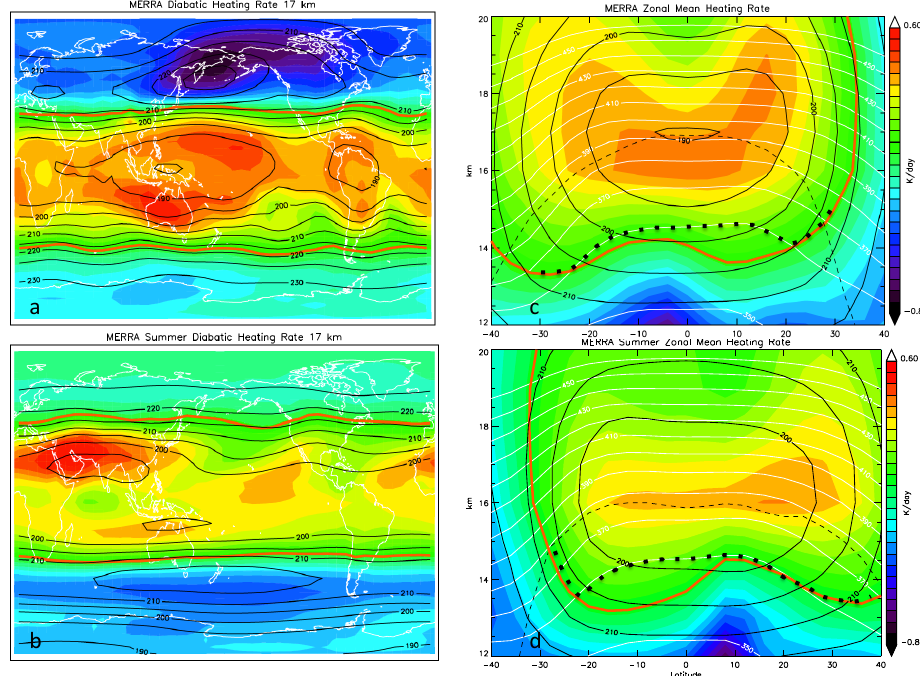
Fig. 1. Heating rates and temperatures from MERRA averaged from 1979–2010. (a) , 17km map of heating rates for Boreal winter (DJF) with temperatures (black contours). Thin orange line is the zero heating contour. (b) , summer (JJA). (c) the zonal mean heating rate and temperatures (black contours) and potential temperatures (white). Dashed line shows the zonal mean tropopause. Black dots illustrate the parcel forcing position used in the model. (d) , summer. The color bar next to the right hand figures indicates the heating rate range in Kday − 1 from –0.8 to 0.6 Kday − 1